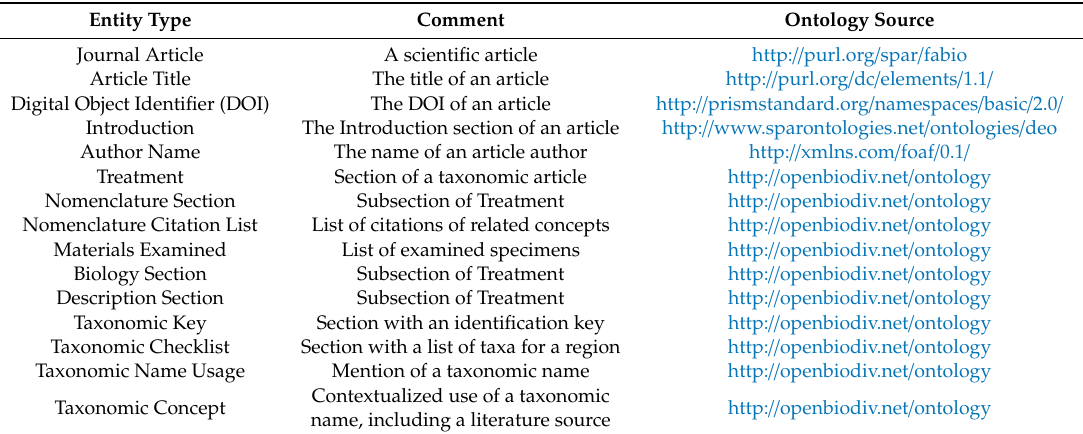
Figure 1. Architectural model of OpenBiodiv. Table 1. Entity types extracted from scholarly literature and represented within OpenBiodiv via the OpenBiodiv-O ontology. The sources for resource types are noted via the ontology URLs. Adapted from Senderov et al. [29].